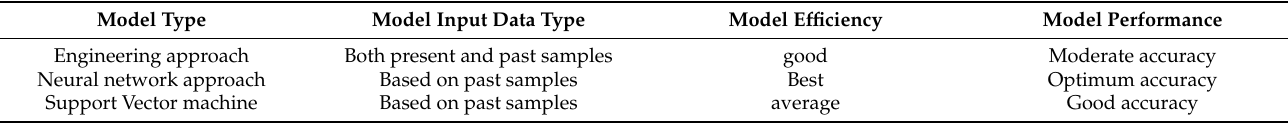
Table 6. Correlation between the estimation strategies